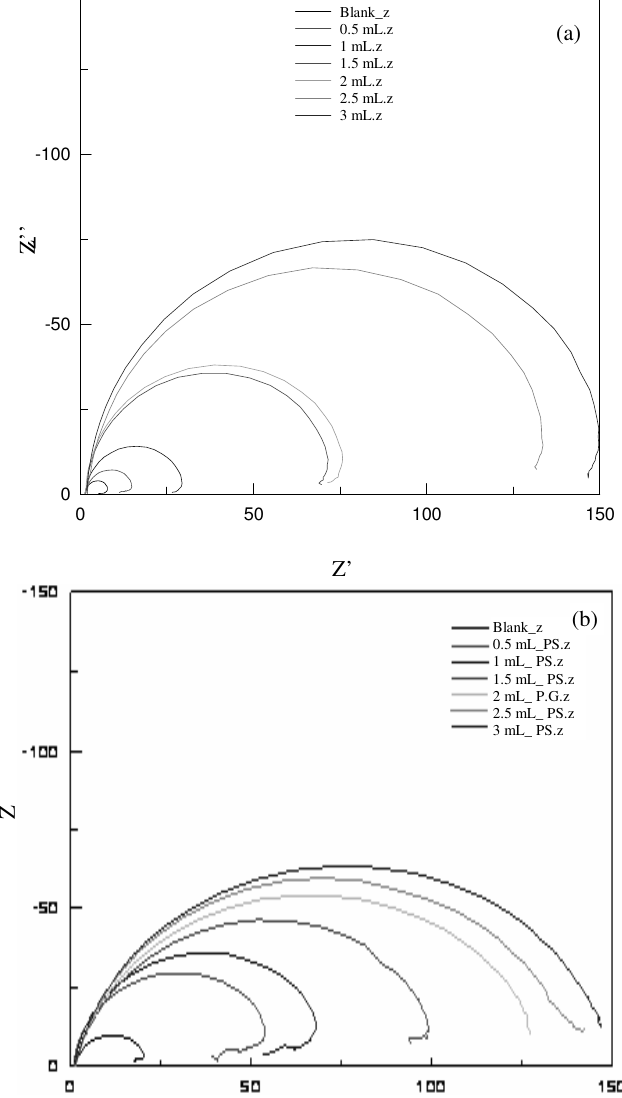
Figure 4. Nyquist plot of mild steel in presence of palmyra palm shell extract in (a) 0.5 M SO and (b) 1 M H 2 4